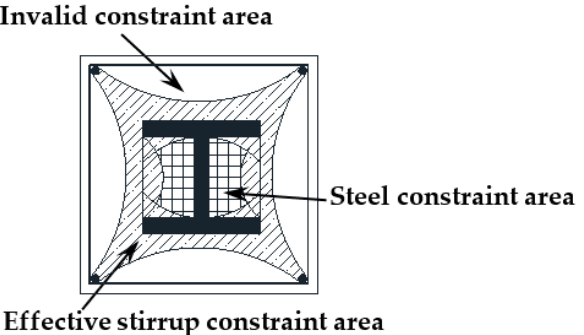
20 of 25 Figure 17. The effects of various parameters on the calculation accuracy: ( a ) the steel ratio; ( b ) the stirrup strength; ( c ) the height of the column; ( d ) the eccentric distance; ( e ) the stirrup spacing; ( f ) the steel strength. 5.3. Correction Based on Stirrup Constraint and Steel Strength From the above analysis, it can be inferred that ignoring the constraining effect of the stirrups and overestimating the effect of steel are the main reasons for the error in the calculations of the specifications. In view of the above problems, this paper puts forward some suggestions for revising the formulas.